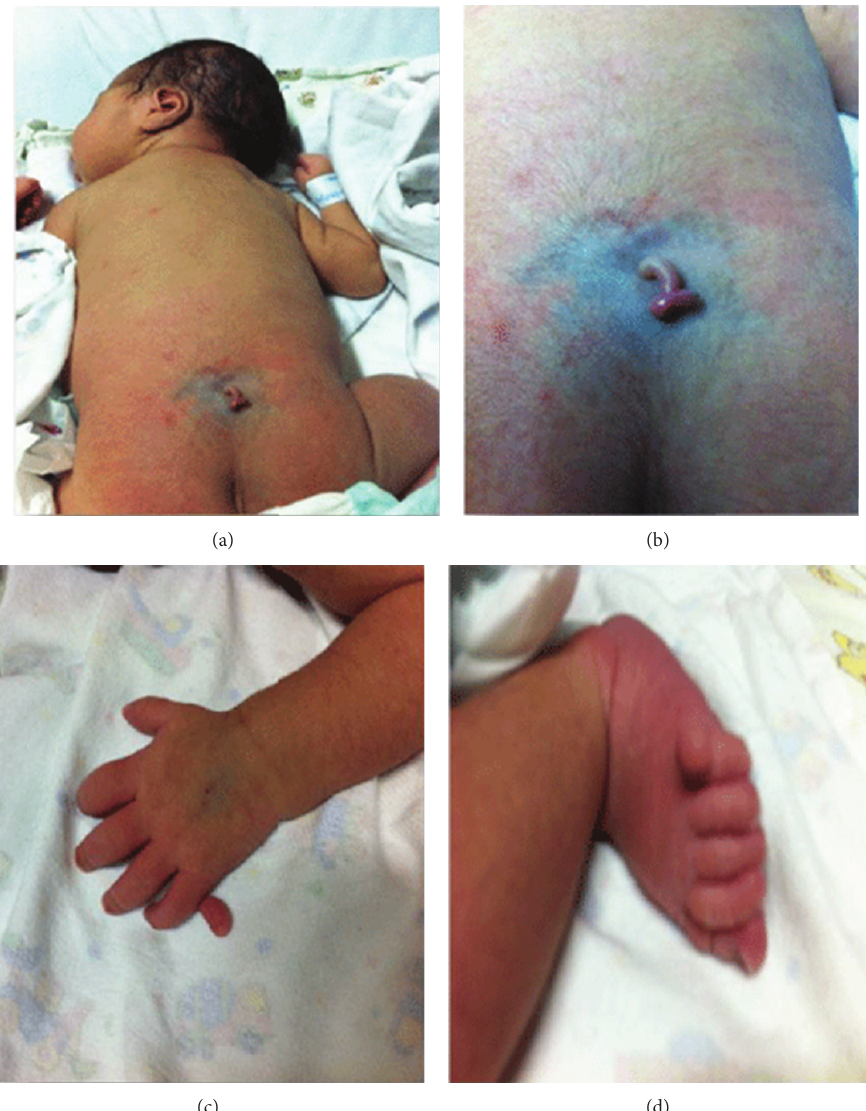
Figure 1: (a) and (b) Cutaneous stigma: skin appendage resembling a tail and violaceous maculae; (c) postaxial polydactyly of the hand; (d) postaxial polydactyly of the feet.